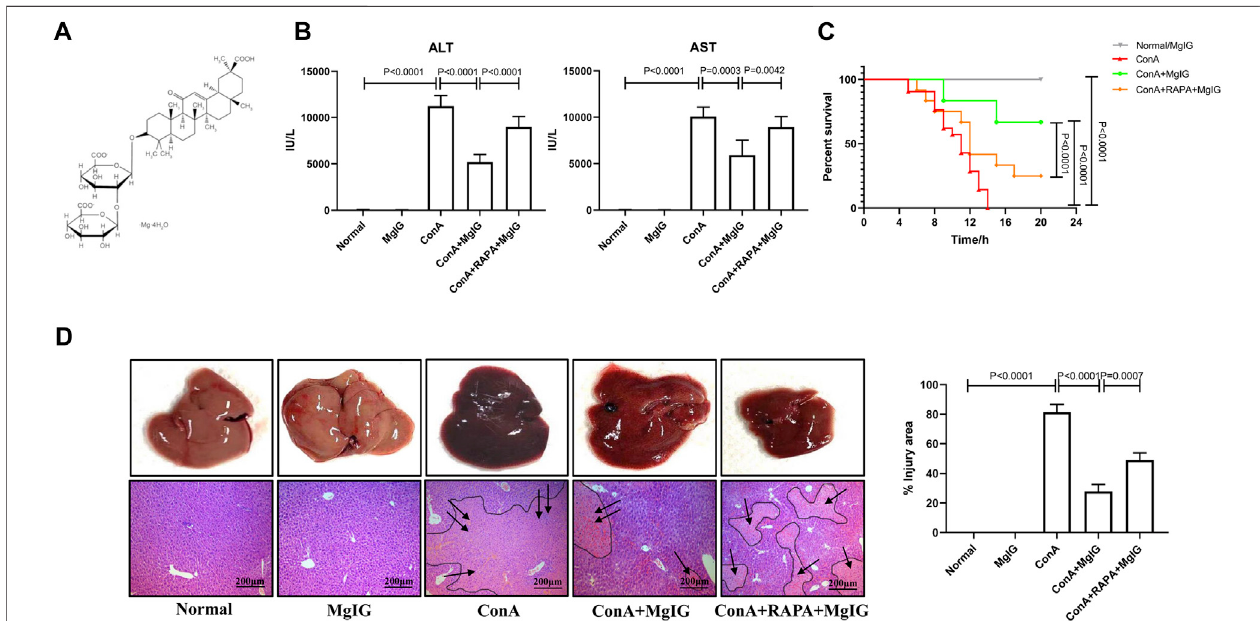
FIGURE 1 | Pretreatment with MgIG ameliorates ConA-induced liver injury in mice. Liver injury was induced by ConA (20 mg/kg, iv, n (cid:1) 8) in mice in the model group. MgIG-treated group mice were administered MgIG (30 mg/kg, ip) 1 h prior to ConA treatment (n (cid:1) 8). Mice in the RAPA intervention group were administered RAPA(2 mg/kg,ip)1 hpriortoConAtreatment(n (cid:1) 8).Controlmicewerepretreatedwithsaline/MgIG1 hpriortoConAadministration(n (cid:1) 4).Thedataareshownasthe mean and SD ofat least three independentexperiments. (A) Chemical structure ofMgIG. (B) Serum ASTand ALT levels in the different groups. (C) Survival curves of the different groups. The administration of MgIG signi fi cantly reduced the mortality of ConA-treated mice. (D) Representative images of liver tissues and H&E-stained liver sections. The areas surrounded by a black line and arrow are areas of liver tissue damage (magni fi cation: 200 × ).